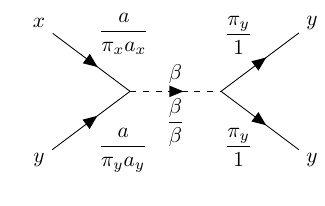
Figure 3. Diagram for interaction x